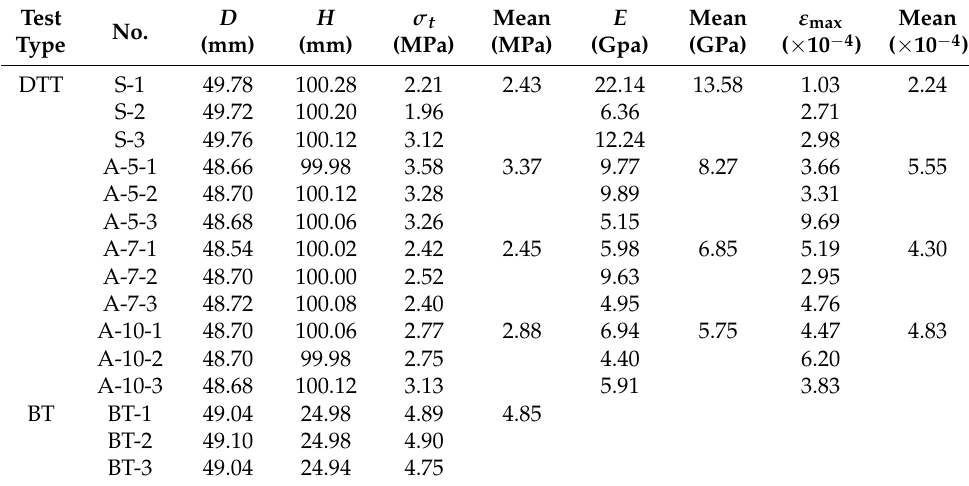
Table 1. Test results of sandstone specimens in DTT and